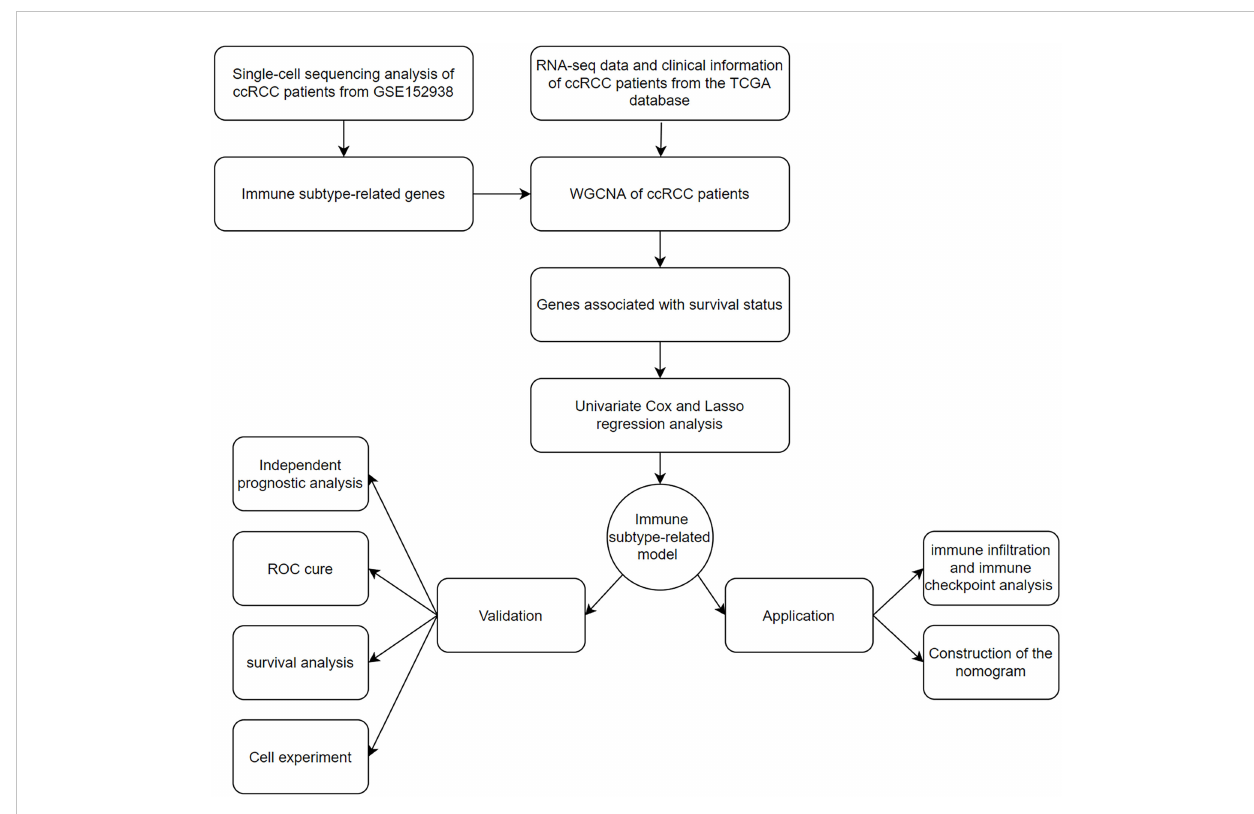
FIGURE 1 The fl owchart of data collection and analysis in this